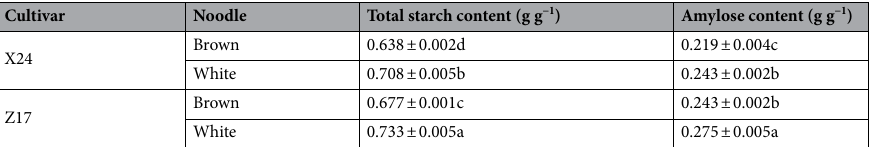
Table 1. Total starch and amylose content in brown and white rice flours processed from two rice cultivars, Xiangzaoxian 24 (X24) and Zhongjiazao 17 (Z17). Data are mean ± SE ( n = 3). Within a column, data sharing the same lowercase letters are not significantly different at the 0.05 probability level.